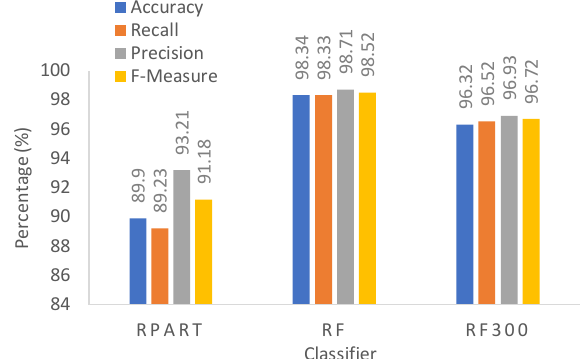
Figure 4. Classifier Performance Metrics after Dimensionality